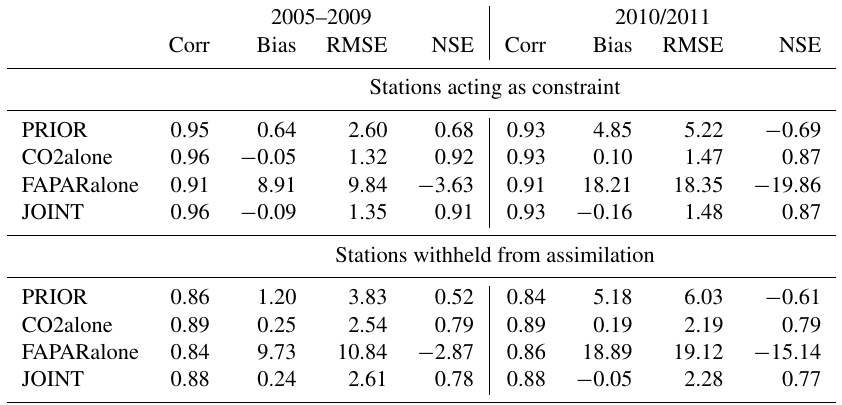
Table 5. Performance of the prior and posterior models compared with atmospheric CO 2 for constraining and evaluating sites and for the assimilation period (2005–2009) and the evaluation period (2010/2011). Abbreviations are Corr: correlation; Bias: model–observations; RMSE: root mean squared error; NSE: Nash–Sutcliffe model